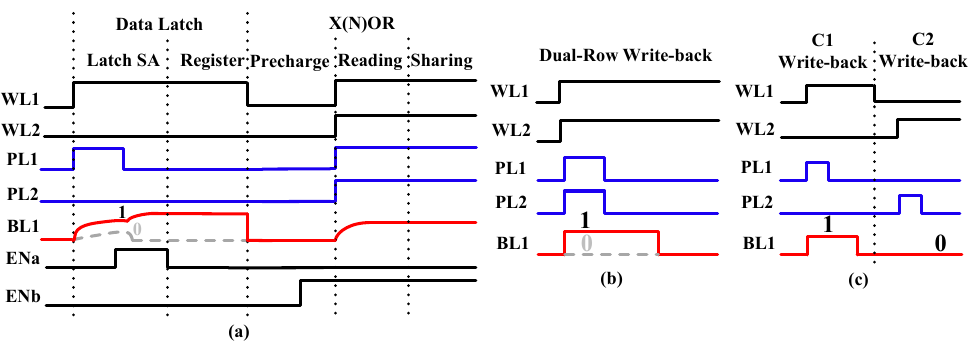
Figure 11. ( a ) The timing of latch data and X(N)OR. ( b ) The timing of write-back when the output of X(N)OR is “0”. ( c ) The timing of write-back when the output of X(N)OR is “1”.